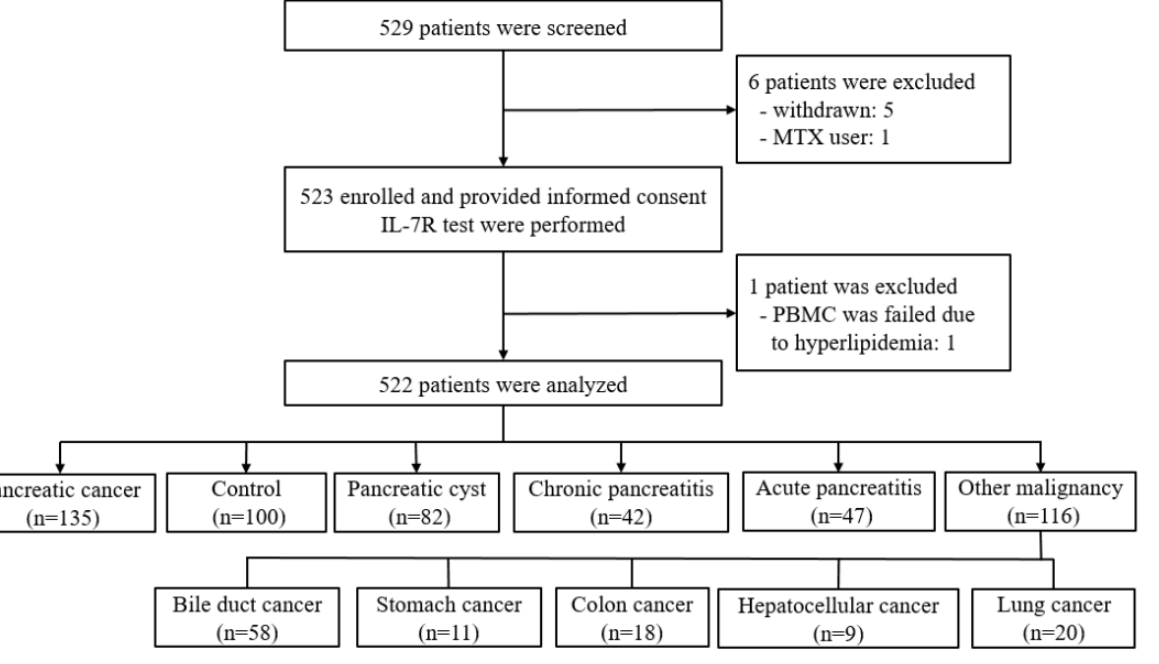
Figure 1. Flow chart of patient selection. MTX, methotrexate; IL-7R, interleukin-7 receptor; PBMC, peripheral blood mononuclear.